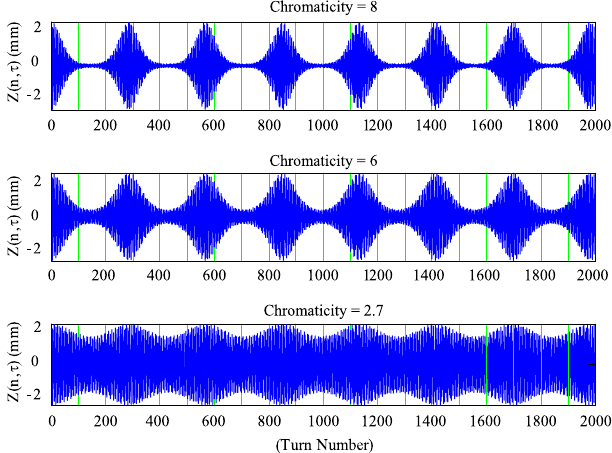
FIG. 4. (Color) Plot of Z (cid:3) n; (cid:1) (cid:4) measured versus n turns. Shown is the transverse beam motion after 1 mm kick with 0.4 nsec longitudinal bunch slices of head (top) and the tail (bottom) each (cid:5) 4 nsecs ). Chromaticity 4 nsecs from the bucket center ( (cid:1) 0 (cid:5) 3 nsecs measured to be (cid:4) (cid:5) 4 : 0 (cid:9) 1 and (cid:8) (cid:1)